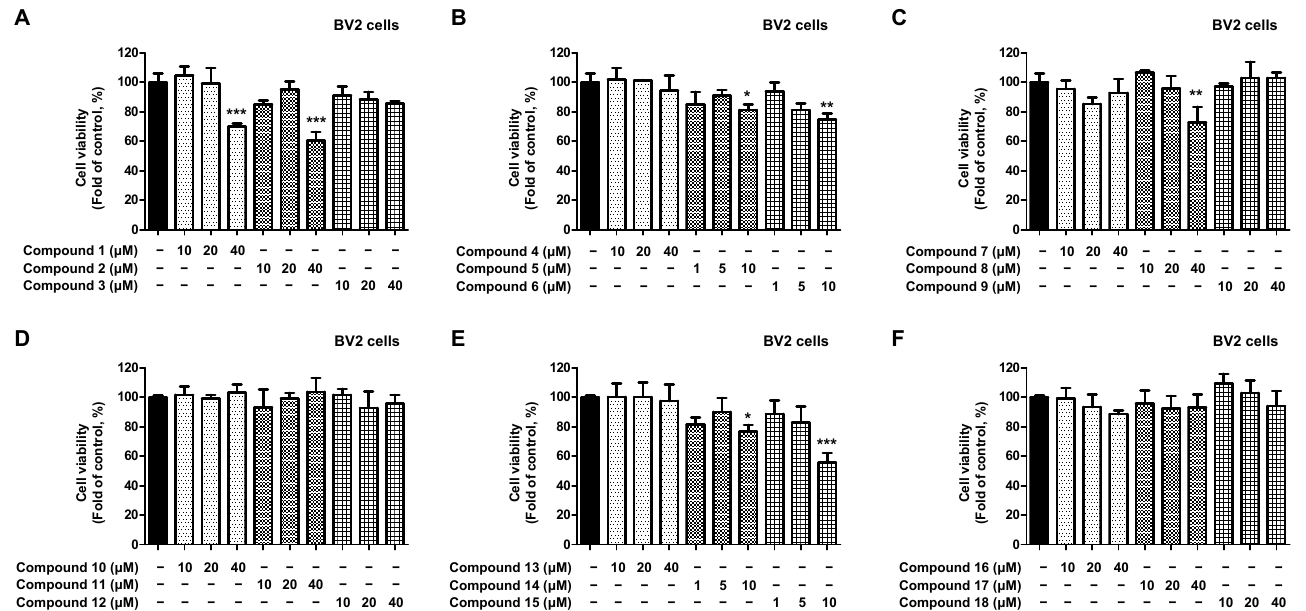
Figure 2. Cytotoxicity of the 18 natural compounds isolated from L. erythrocarpa leaves assayed in BV2 microglia cells ( A – F ). Cytotoxicity was assessed after treatment with the compounds at concentrations of 1–40 µ M for 48 h. Data are presented as the mean ± standard deviation values of three independent experiments. * p < 0.05, ** p < 0.01, *** p < 0.001 vs. control.